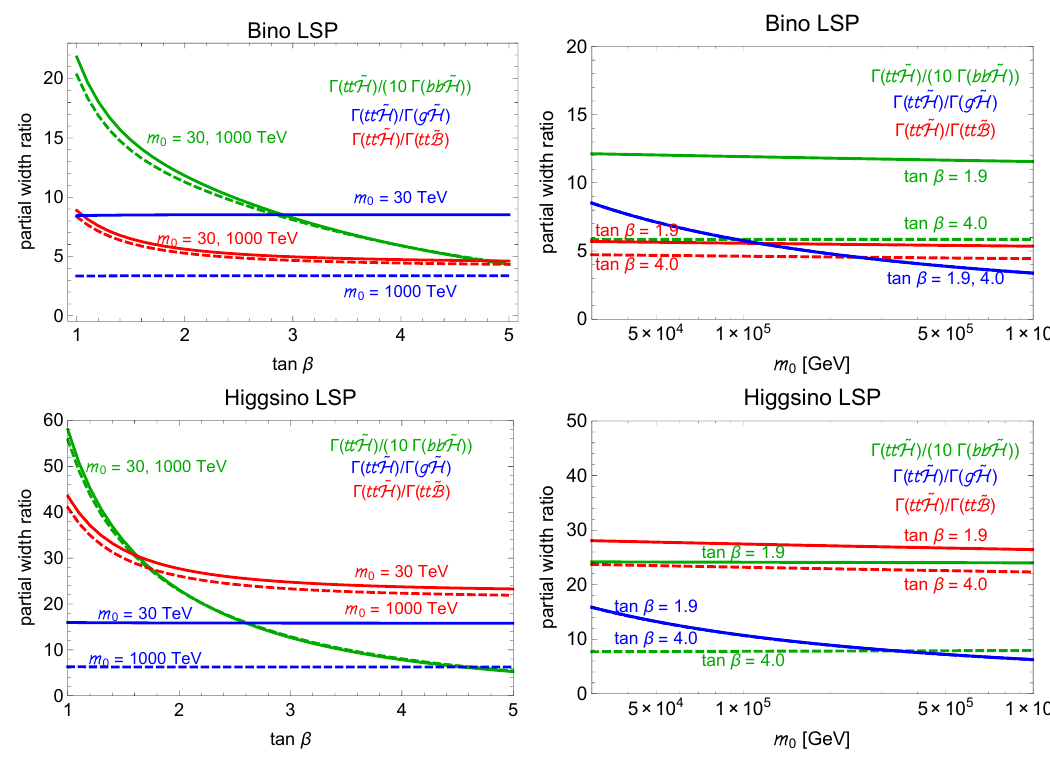
Figure 4 . Gluino branching ratios, plotted as functions of a universal scalar mass scale m tan (cid:12) . We choose two benchmark points, both with M 3 = 2 TeV: in the top row, M 1 = 200 GeV, M 2 = 400 GeV, and (cid:22) = 800 GeV; in the bottom row, M 1 = 700 GeV, M 2 = 1 TeV, and (cid:22) = 200 GeV. Because the bb width is very small, we have multiplied it by 10 to make the green curves visible in the